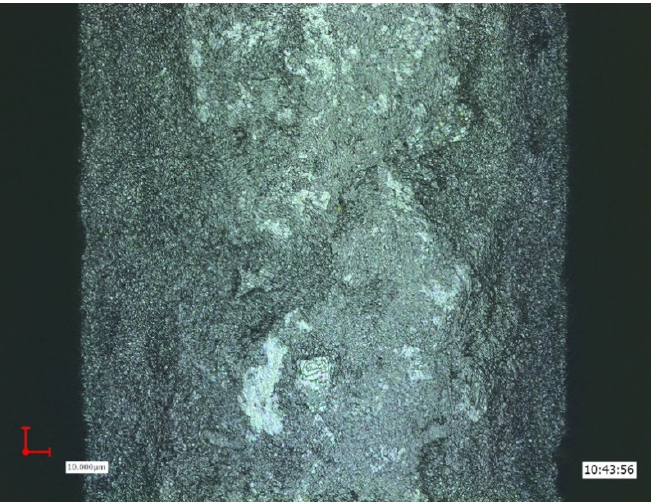
Figure 5. Sandblasted implant surface demonstrating areas of change after insertion.